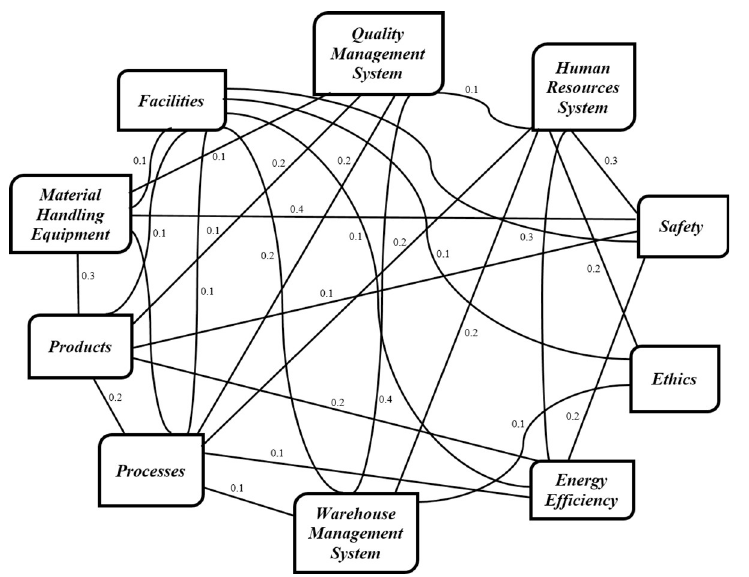
Fig 3. The network structure with the strength values of the